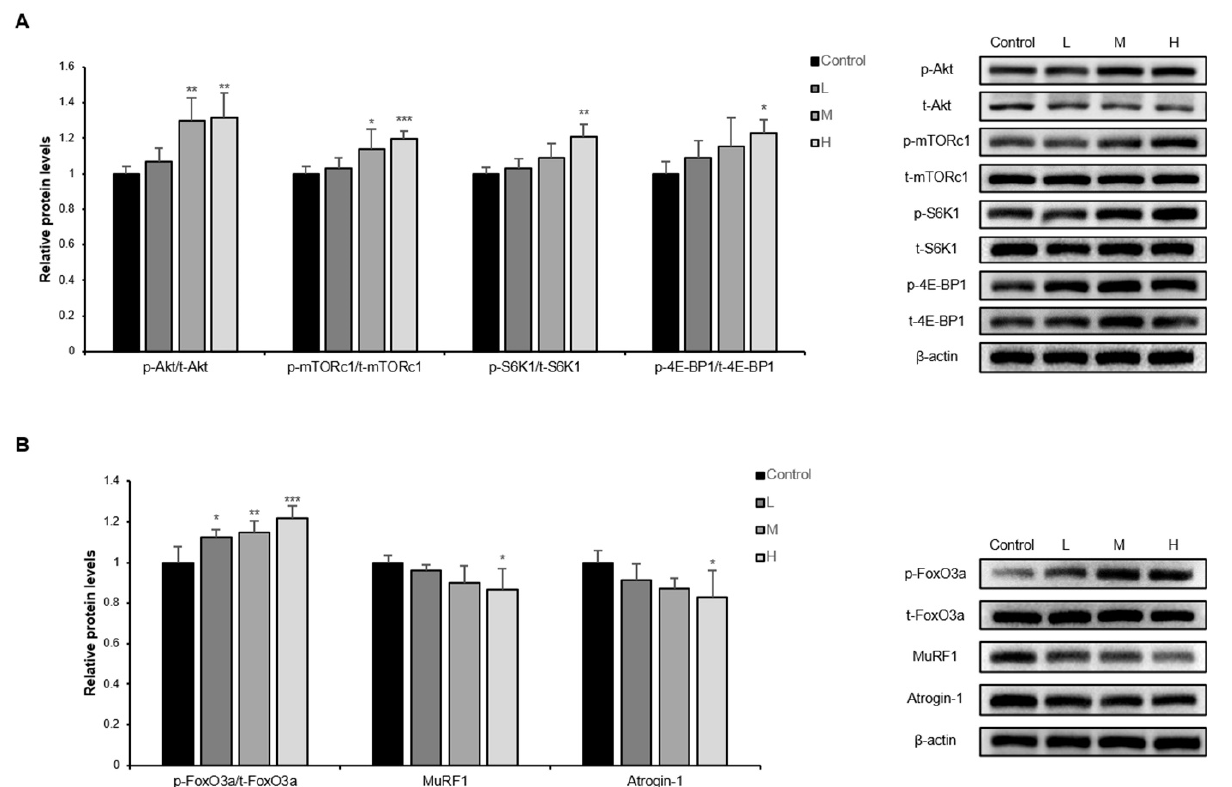
Figure 3. Effect of the GBE + WPH mixture on muscle protein synthesis and degradation mechanisms. Ten-month-old male C57BL/6 mice were administered three different doses of the GBE + WPH mixture for 8 weeks; 700 mg/kg, 900 mg/kg, and 1100 mg/kg. ( A ) Relative protein expression of factors related to muscle protein synthesis (p-Akt/t-Akt, p-mTORc1/t-mTORc1, p-S6K1/t-S6K1, and p-4E-BP1/t-4E-BP1) and Western blot images. ( B ) Relative protein expression of factors related to muscle protein degradation (p-FoxO3a/t-FoxO3a, MuRF1, and Atrogin-1) and Western blot images. The protein expression levels were normalized to β -actin level. The data are shown as mean ± SD. * p < 0.05, ** p < 0.01, *** p < 0.001 versus control.